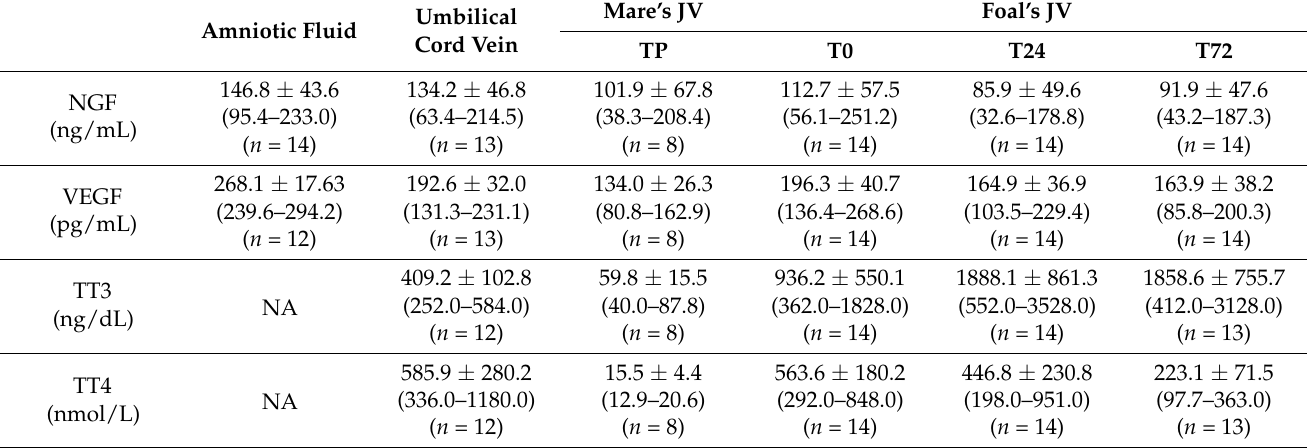
Table 3. NGF –VEGF levels in amniotic fluid and in plasma samples obtained from umbilical cord vein, mare’s jugular vein (JV) at parturition (TP) and foal’s jugular vein (JV ) at three consecutive time points (T0: birth; T24: 24 h from birth; T72: 72 h from birth); TT3 –TT4 levels in serum samples obtained from umbilical cord vein, mare’s jugular vein at parturition (TP) and f oal’s jugular vein at three consecutive time points (T0: birth; T24: 24 h from birth; T72: 72 h from birth). n = number of dosed samples; NA = data not available. Data are expressed as mean ± standard deviation (min – max).